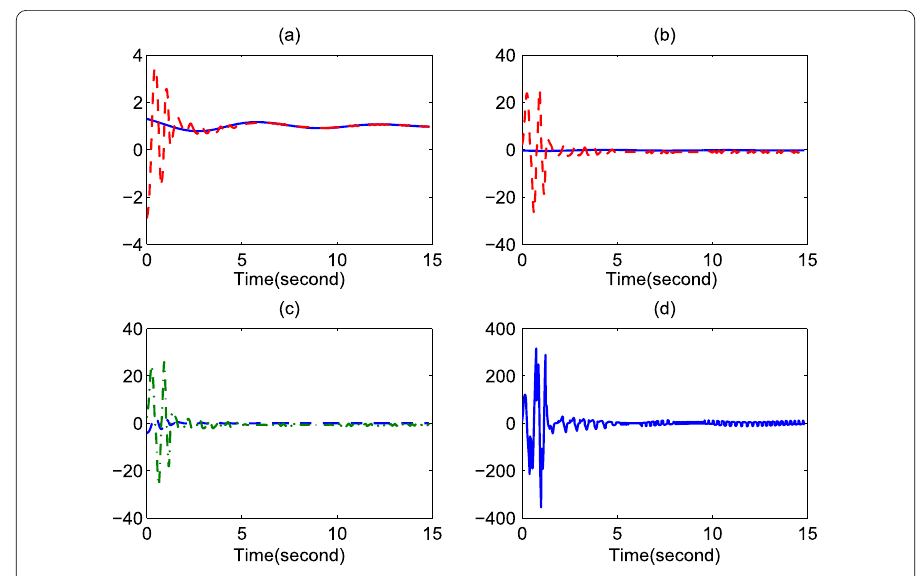
Figure 3 The simulation results. ( a ) The 1st signal trajectories, x 1 ( t ) (solid line) and y 1 ( t ) (dotted line). ( b ) The 2nd signal trajectories, x 2 ( t ) (solid line) and y 2 ( t ) (dotted line). ( c ) The synchronization error trajectories, e 1 ( t ) (dotted line) and e 2 ( t ) (dashed line). ( d ) The control input trajectory, u ( t